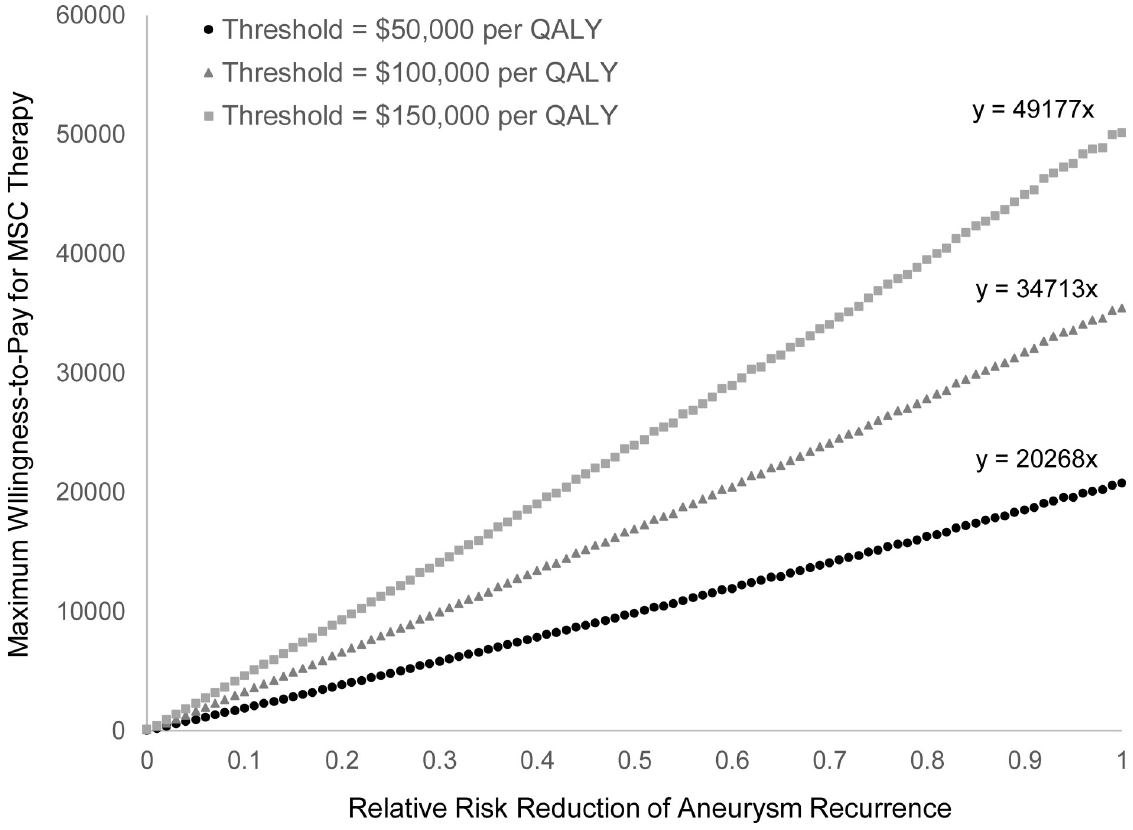
Fig 2. HTI cost-elasticity curve: How changes in HTI efficacy influence the maximum cost-effective price at various thresholds. Note: All currency represented in 2018 United States dollars. Equations can be used to calculate y (the maximum price the healthcare payer willing to pay for the HTI) for a given efficacy ( x ). Alternatively, equations can be rearranged to calculate x , minimum relative risk reduction in aneurysm recanalization the HTI must achieve in order to be cost-effective for a given price ( y ). Abbreviations: HTI–health technology innovation; MSC–mesenchymal stem cell; QALY–quality-adjusted